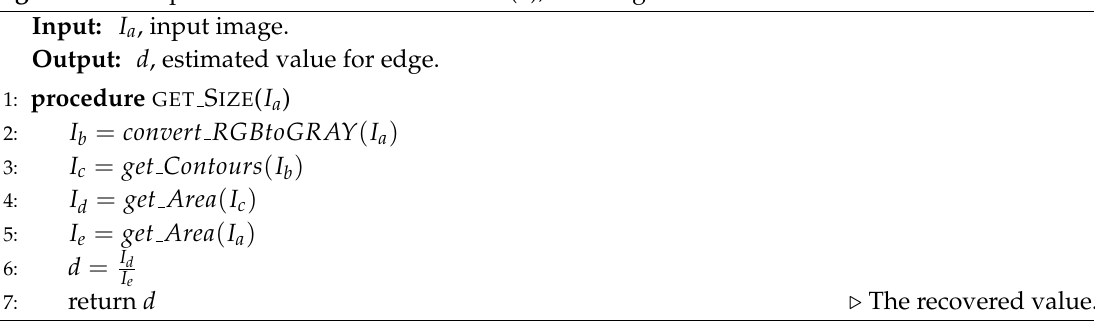
Algorithm 3 Proposed method to evaluate size ( d ), showing lines 1–7.